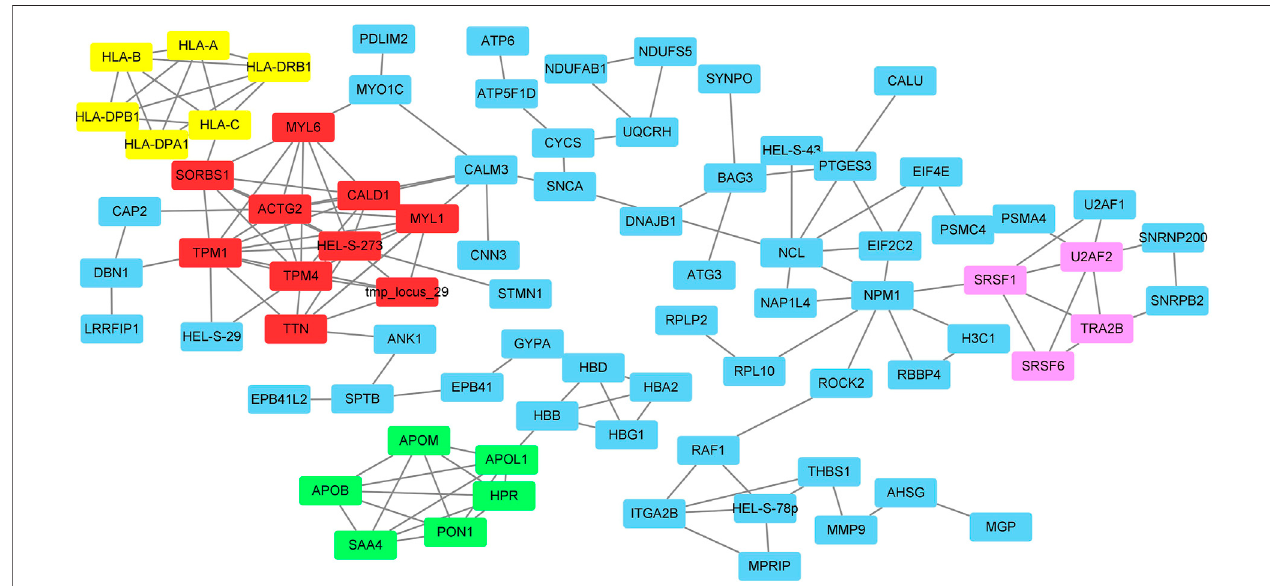
FIGURE2| Theprotein-proteininteractionsofDEPsandtheclustersidenti fi edbyMCODE.Redbox:cluster1;Greenbox:cluster2;Yellowbox:cluster3;Pinkbox: cluster 4.